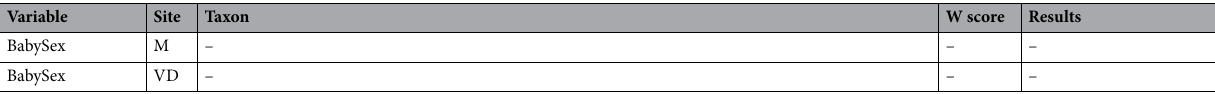
Table 3. Summary of the results from analysis of composition of microbiomes (ANCOM) at the genus level. AF, amniotic fluid; CB, umbilical cord blood; GL, gastric liquid; M, meconium; VD, cervicovaginal discharge. a Significant hits were found by ANCOM, but these results were discarded as they have a very low W score (zero in many cases) and are likely artifacts; note that this is a known bug in ANCOM, typically caused by small sample size for a given test. b Amplicon sequence variants were labelled ‘Unassigned’ if it was not possible to classify them at the highest taxonomic level at the required confidence level. c These amplicon sequence variants could not be classified beyond the domain level at the required confidence level.